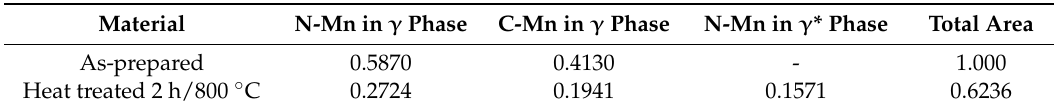
Table 1. Areas under specific i-s pair contributions, normalized to that of the Q −1 peak of the as-